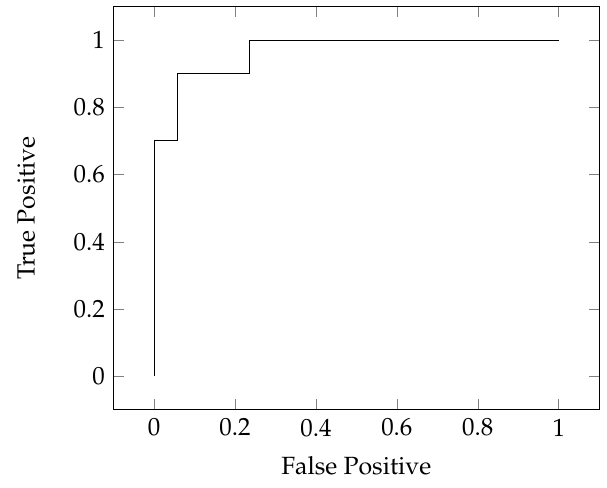
Figure 10. ROC curve for the event e 15 .